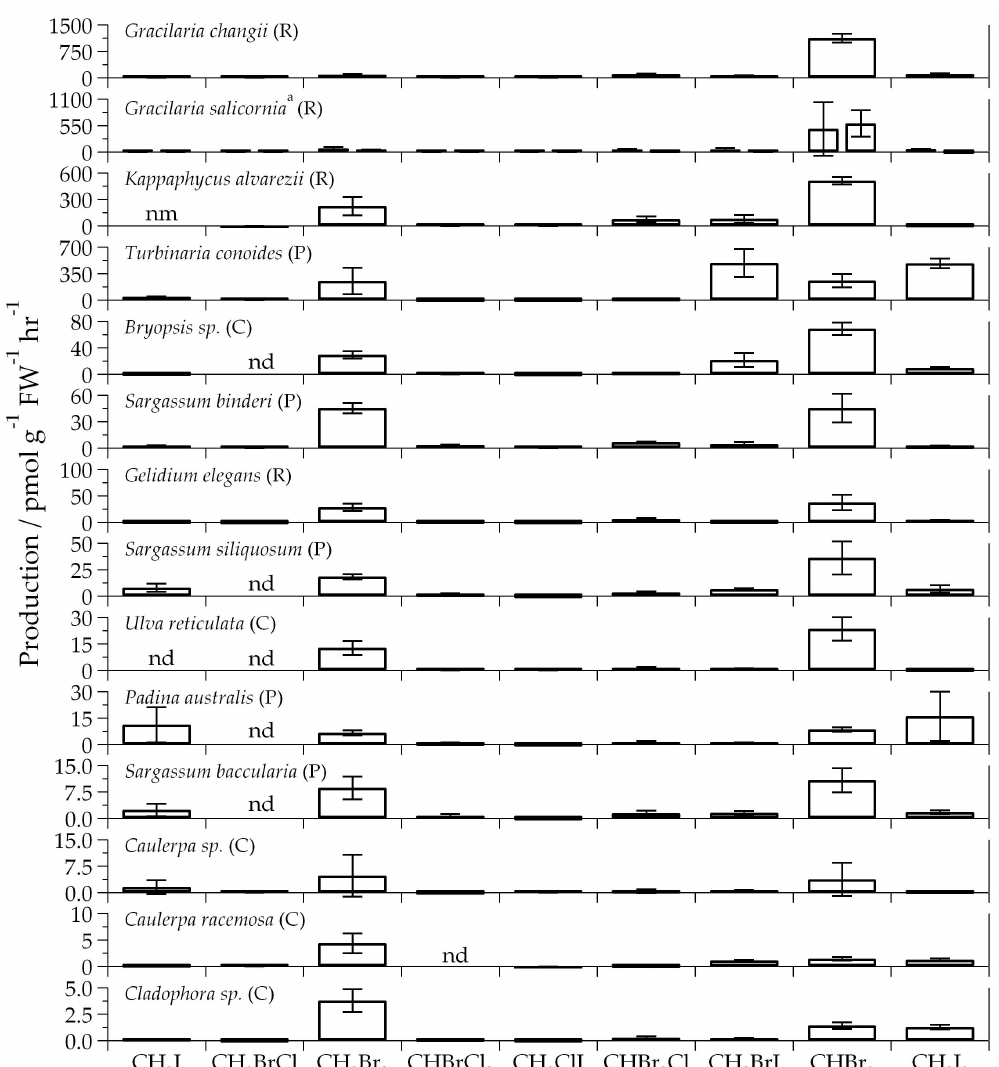
Fig. 3. Halocarbon production by tropical macrophytes measured at t 24. Bars are mean production of biological replicates ( n = 2 or 3, see Table 1) with error bars the 1 σ standard deviation. R=rhodophyte, P=phaeophyte, C=chlorophyte. “nm” is “not measured” and “nd” is “not detected”. (a) G. salicornia was incubated twice (see Table